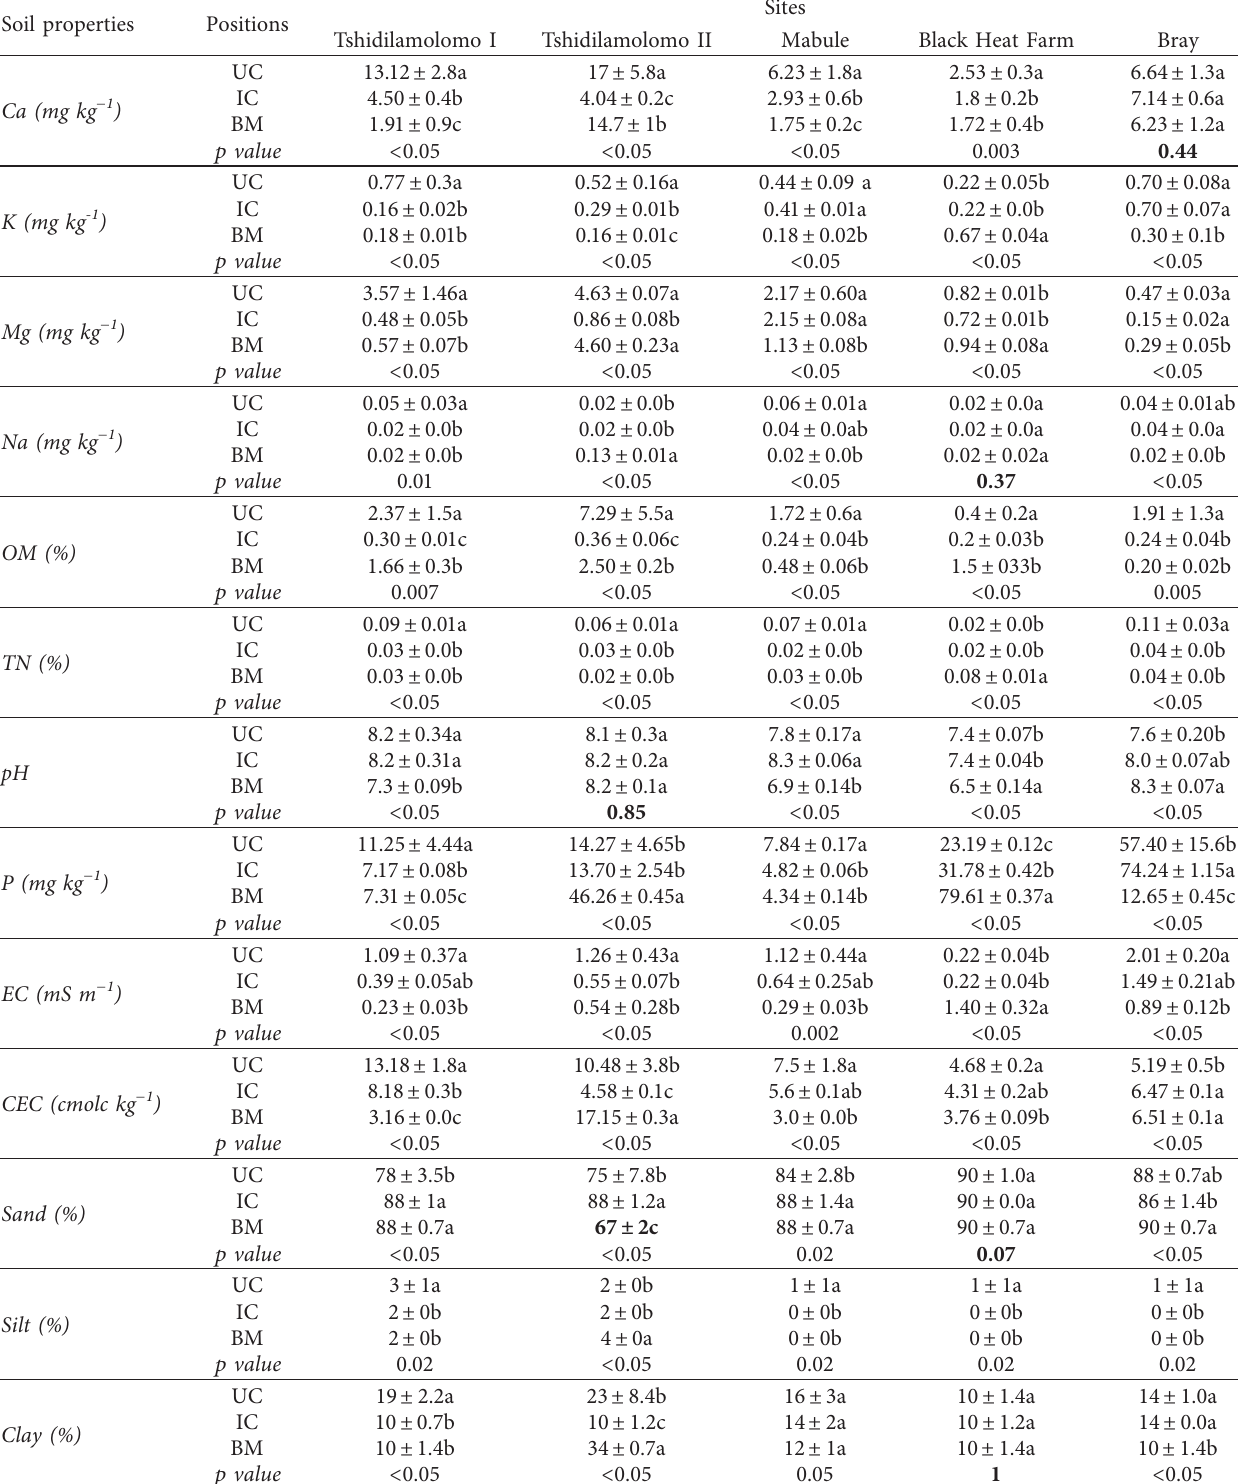
Table 2: Mean ( ± SEM) of selected soil properties in three soil stands at five study sites Influenced by Prosopis species. Soil